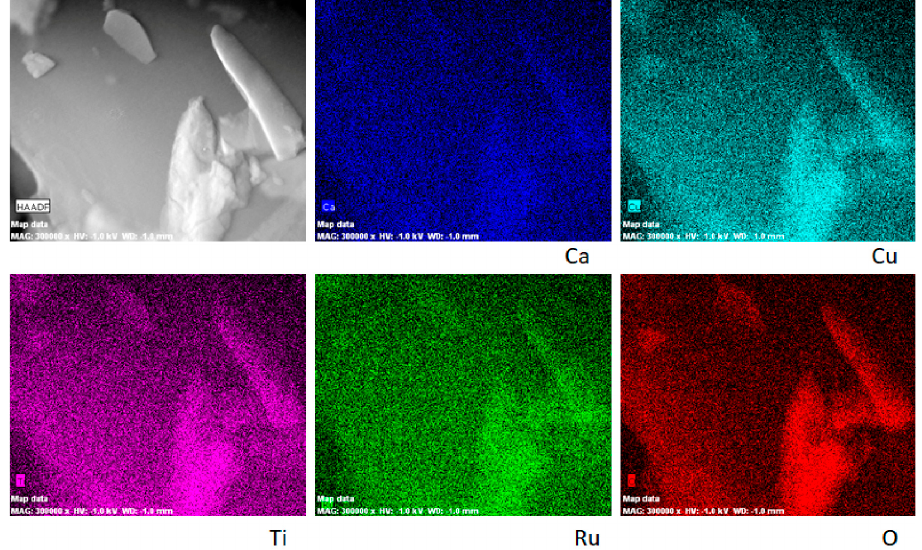
Figure 5. ADF/STEM analysis and EDXS elemental mapping of CCT3RO powder.